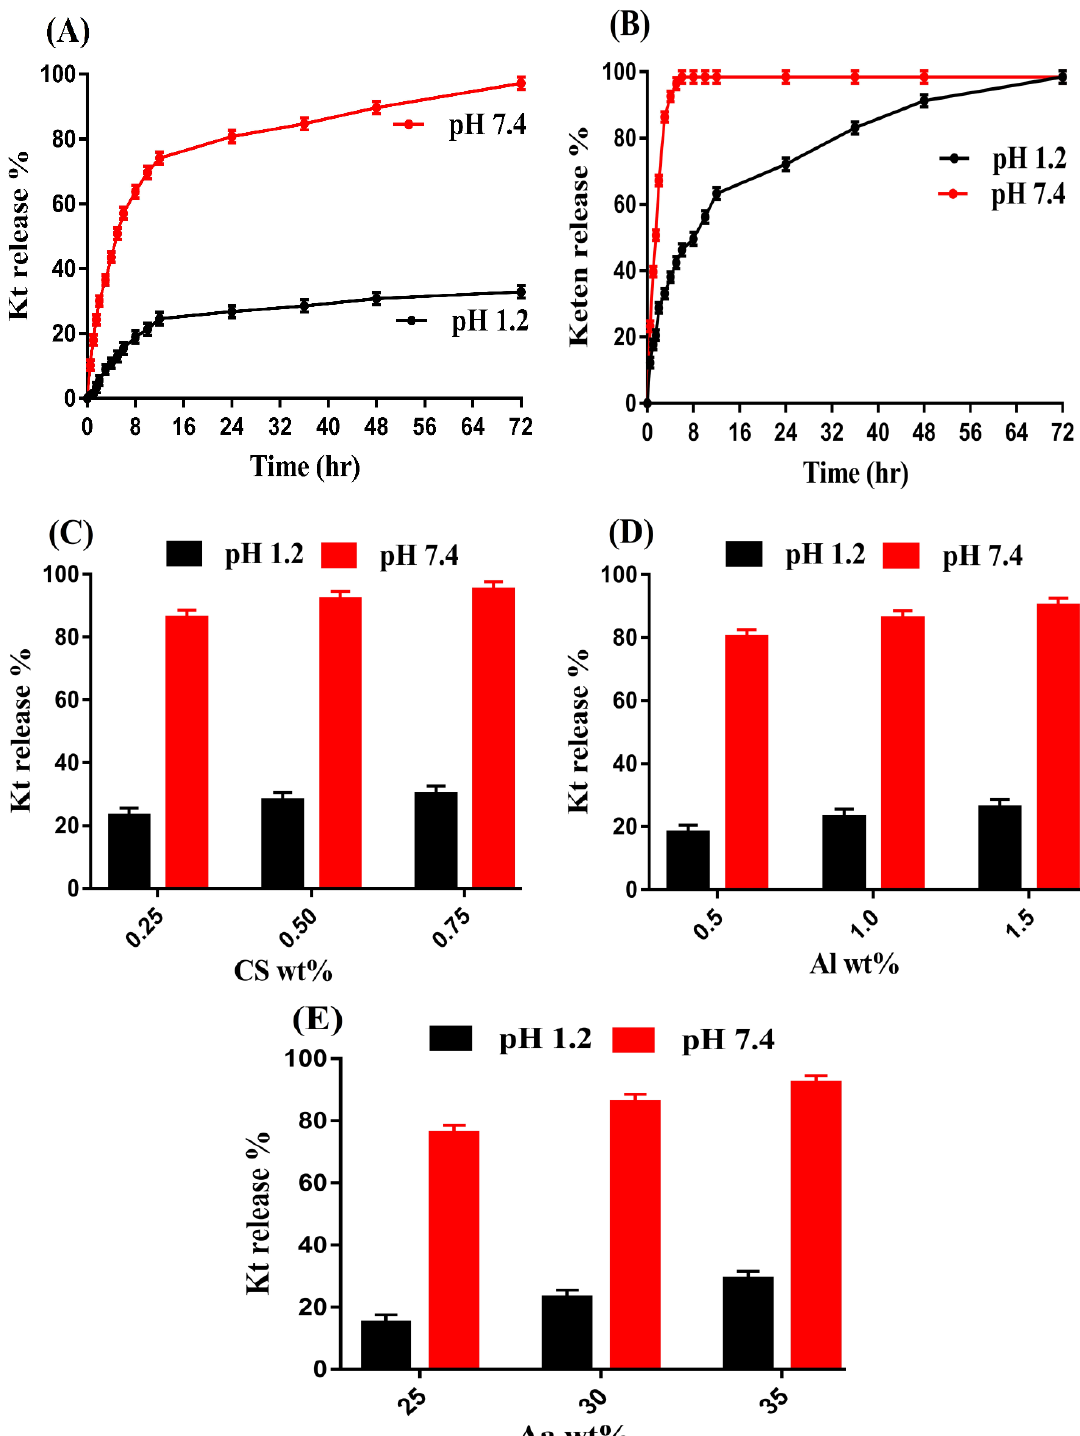
Figure 8. Effect of pH on drug release from ( A ) CS/Al-g-pAa hydrogel, ( B ) Keten, and Effect of ( C ) CS, ( D ) Al, and ( E ) Aa on drug release from CS/Al-g-pAa hydrogel.